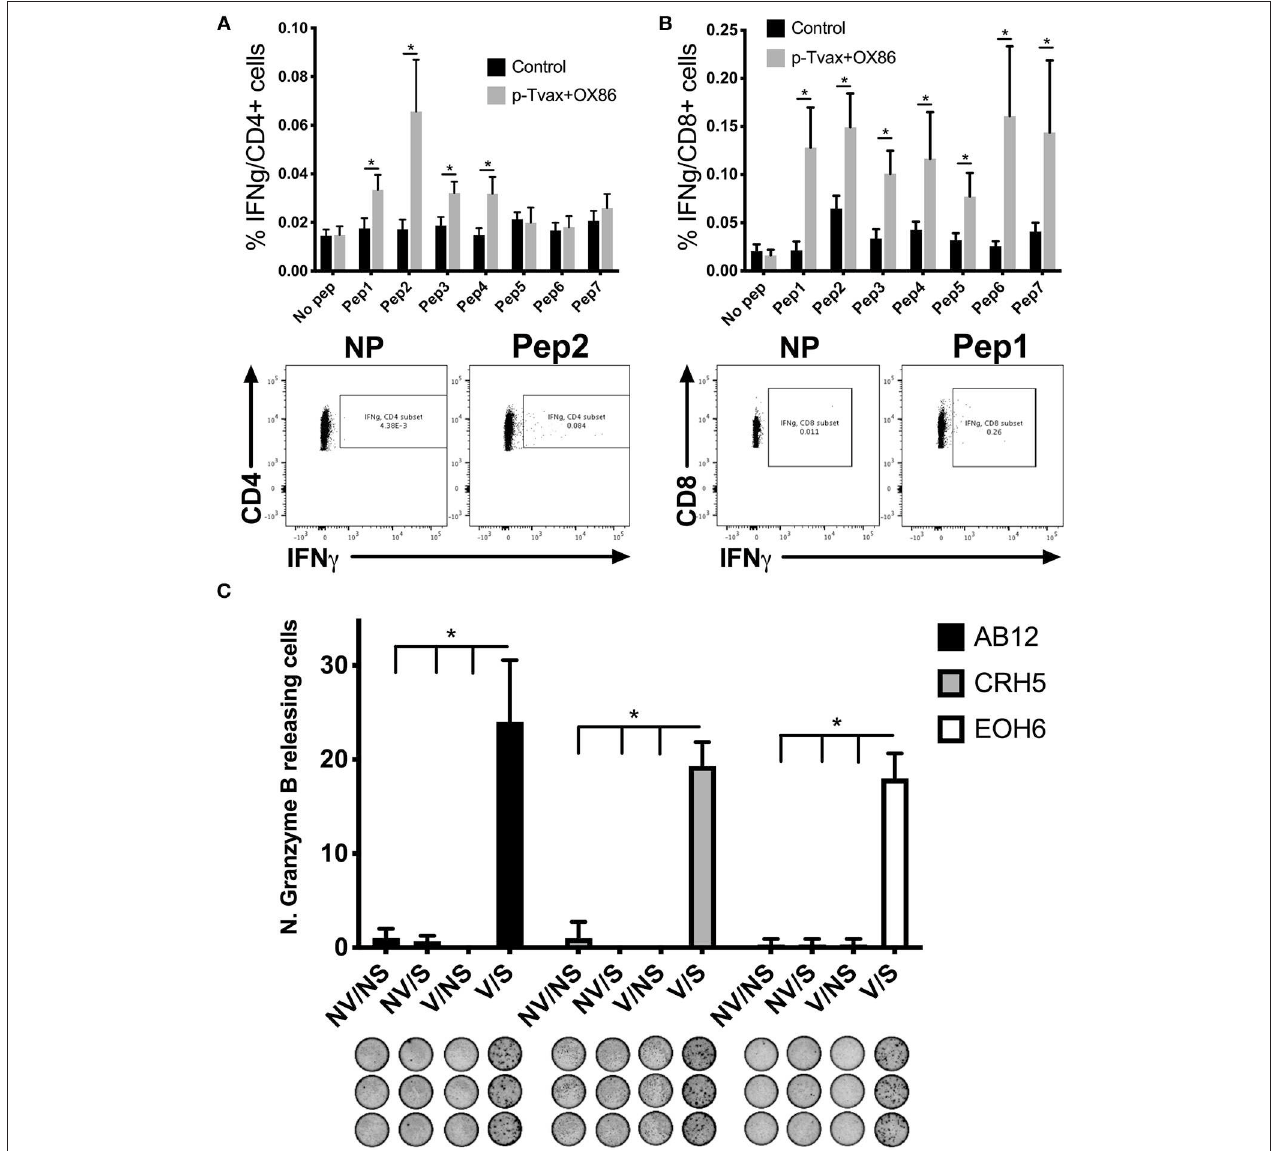
FIGURE 2 | p-Tvax stimulates antigen-specific IFN- γ secreting T lymphocytes that produce Granzyme B when co-cultured with MM cells. BALB/c mice were vaccinated with two s.c. injections of p-Tvax peptides at days 2 and 9. CpG 1585 was used as adjuvant and injected at the same site of the p-Tvax peptides 2 days before vaccination, at days 0 and 7. OX40 agonist mAbs (OX86) were i.p. injected at days 4 and 9. Control mice were left untreated. Five days after the last vaccination, spleen cells were isolated and enumerated for assays. (A) Intracellular IFN- γ in CD4 + T cells was evaluated by flow cytometric ICS analyses of spleen cells cultured with or without p-Tvax peptides. Percentage of IFN- γ expressing CD4 + T cells are presented as mean ± S.E. Bottom Panel: Representative data from flow cytometric analysis of vaccinated and control mice. Lymphocytes were either unstimulated (no peptide = NP) or stimulated with peptide 2. CD4 + T cells were distinguished using a marker gate in the CD3 vs. CD4 dot plot. (B) IFN- γ in CD8 + T cells was evaluated in spleen cells cultured with or without p-Tvax peptides. Percentage of IFN- γ expressing CD8 + T cells are presented as mean ± S.E. Bottom Panel: Representative data from flow cytometric analysis of vaccinated and control mice. Lymphocytes were either not stimulated (NP) or stimulated with peptide 1. CD8 + T cells were distinguished using a marker gate in the CD3 vs. CD8 dot plot. For A and B, statistical significance between treated and control groups was determined by ANOVA followed by Bonferroni test (* p < 0.05, n = 5). (C) Secretion of Granzyme B was evaluated by ELISPOT assay. Spleen cells from vaccinated mice (V) or unvaccinated (no vaccine = NV) were activated with p-Tvax peptides in the presence of 5 IU/ml IL-2 for 6 d (stimulation = S) or incubated with no peptide (no stimulation = NS). Following 4h of incubation with different MM cells (AB12, CRH5, EOH6), the number of spot-forming cells per 10 5 cells was evaluated and results represented as mean ± S.E. Statistical differences between vaccinated mice, stimulated with peptides (V/S), and the other control conditions were evaluated by ANOVA followed by Bonferroni test (* p < 0.05, n = 3).